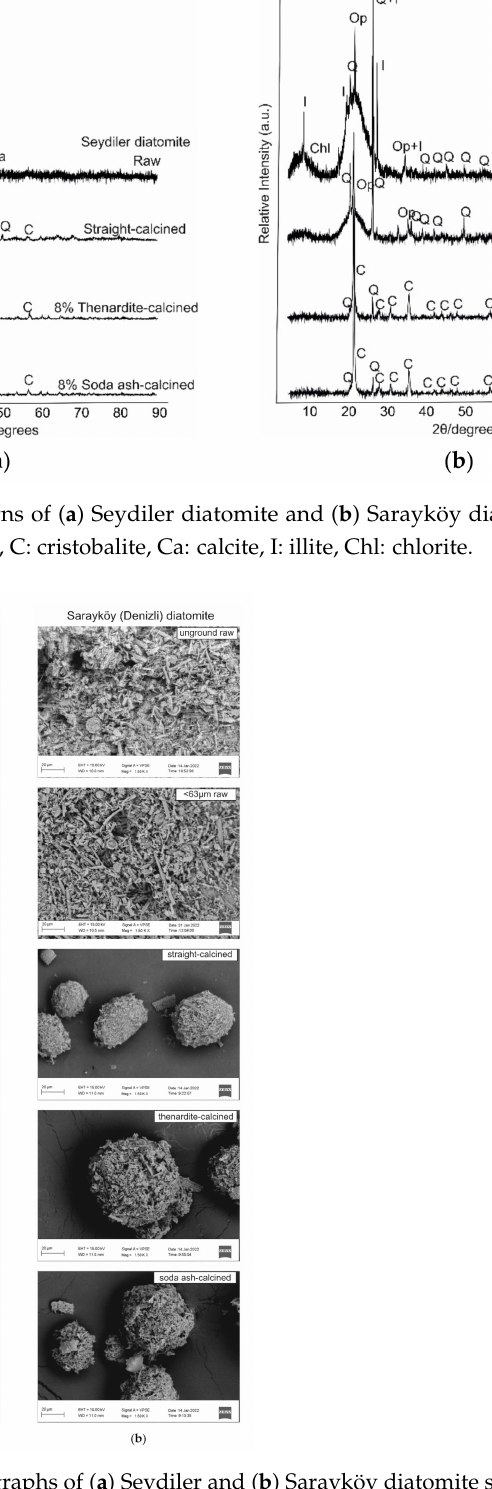
Figure 5. SEM micrographs of ( a ) Seydiler and ( b ) Sarayköy diatomite